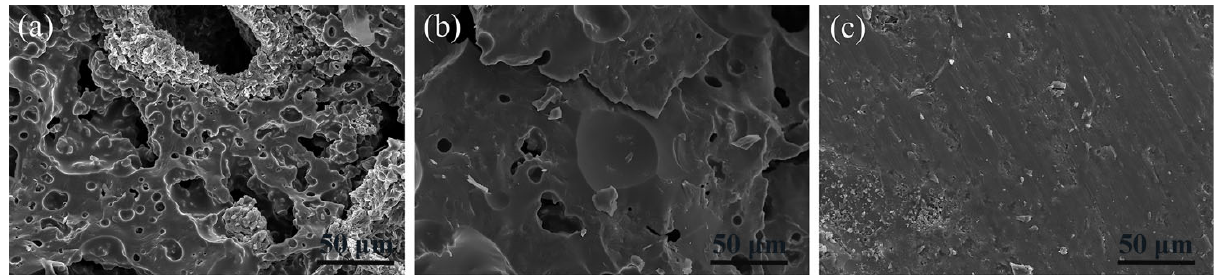
Figure 8. SEM photographs of the sample SSP-2 cross-sections taken under magnification of × 500; ( a ) 700 ◦ C, ( b ) 850 ◦ C, and ( c ) 1000 ◦ C.